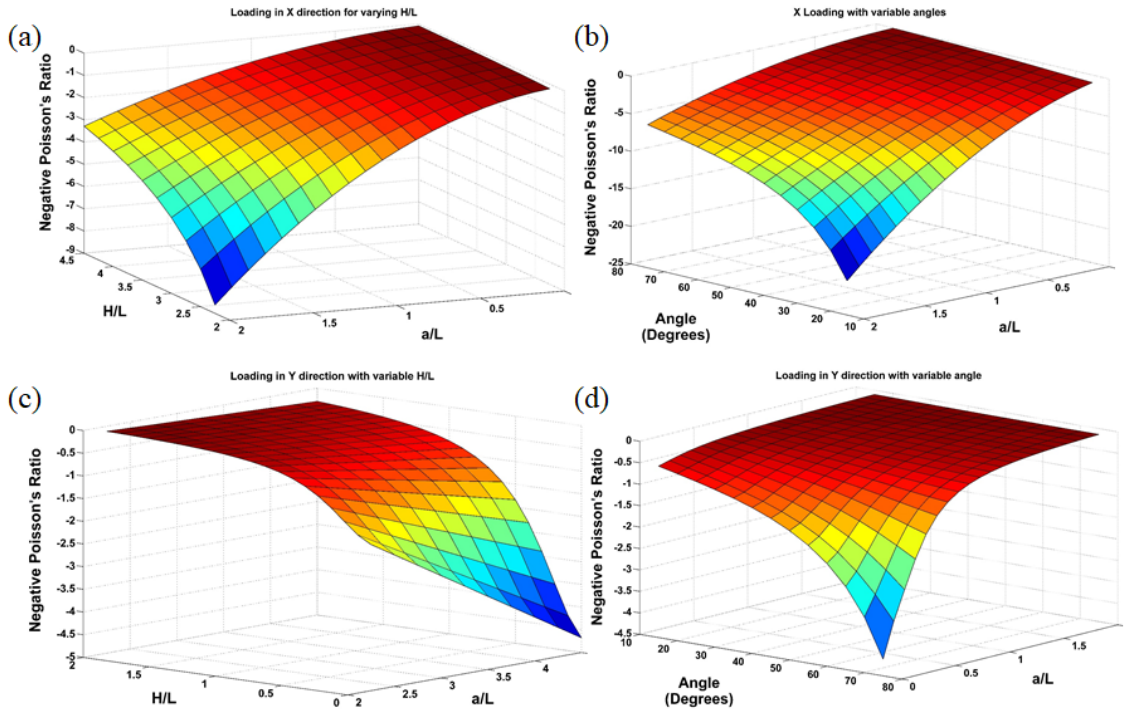
Figure 17. NPR for different values of H/L, a/L , and re-entrant angle for ( a , b ) x-direction loading and ( c , d ) y-direction loading.